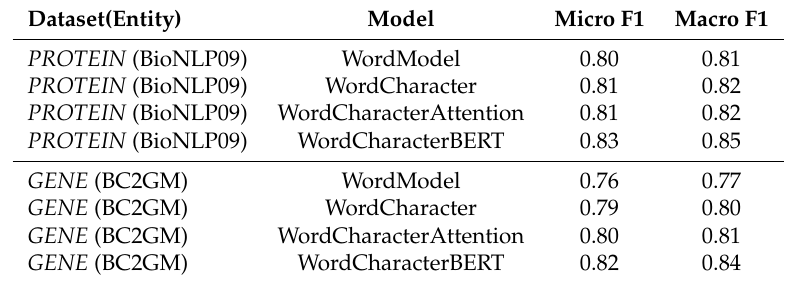
Table 8. Without transfer : Micro- and macro-averaged F1 scores for NER in BioNLP09 and BC2GM.